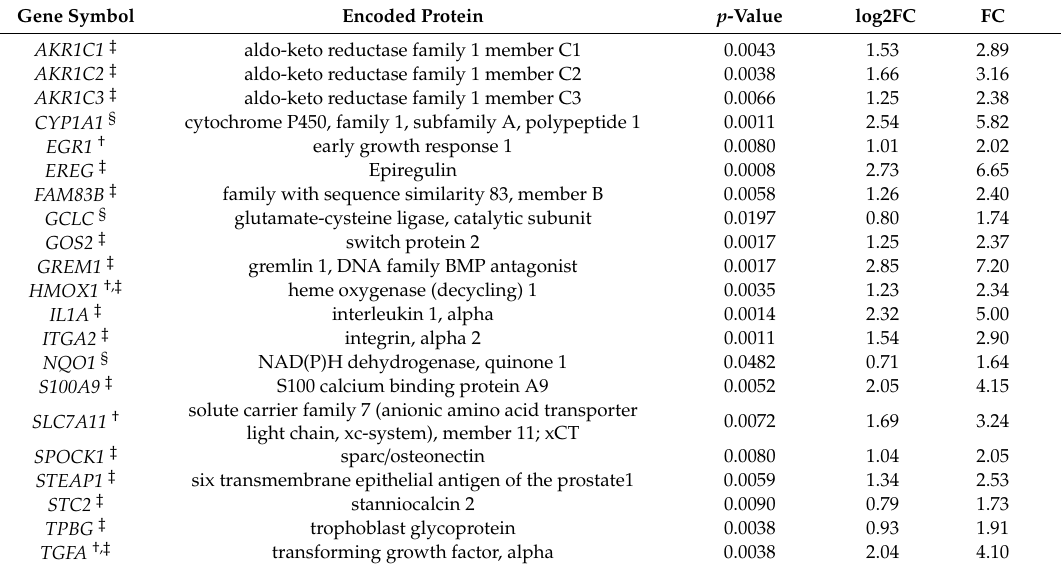
Table 1. Nrf2-associated, upregulated genes upon long-term exposure to PM